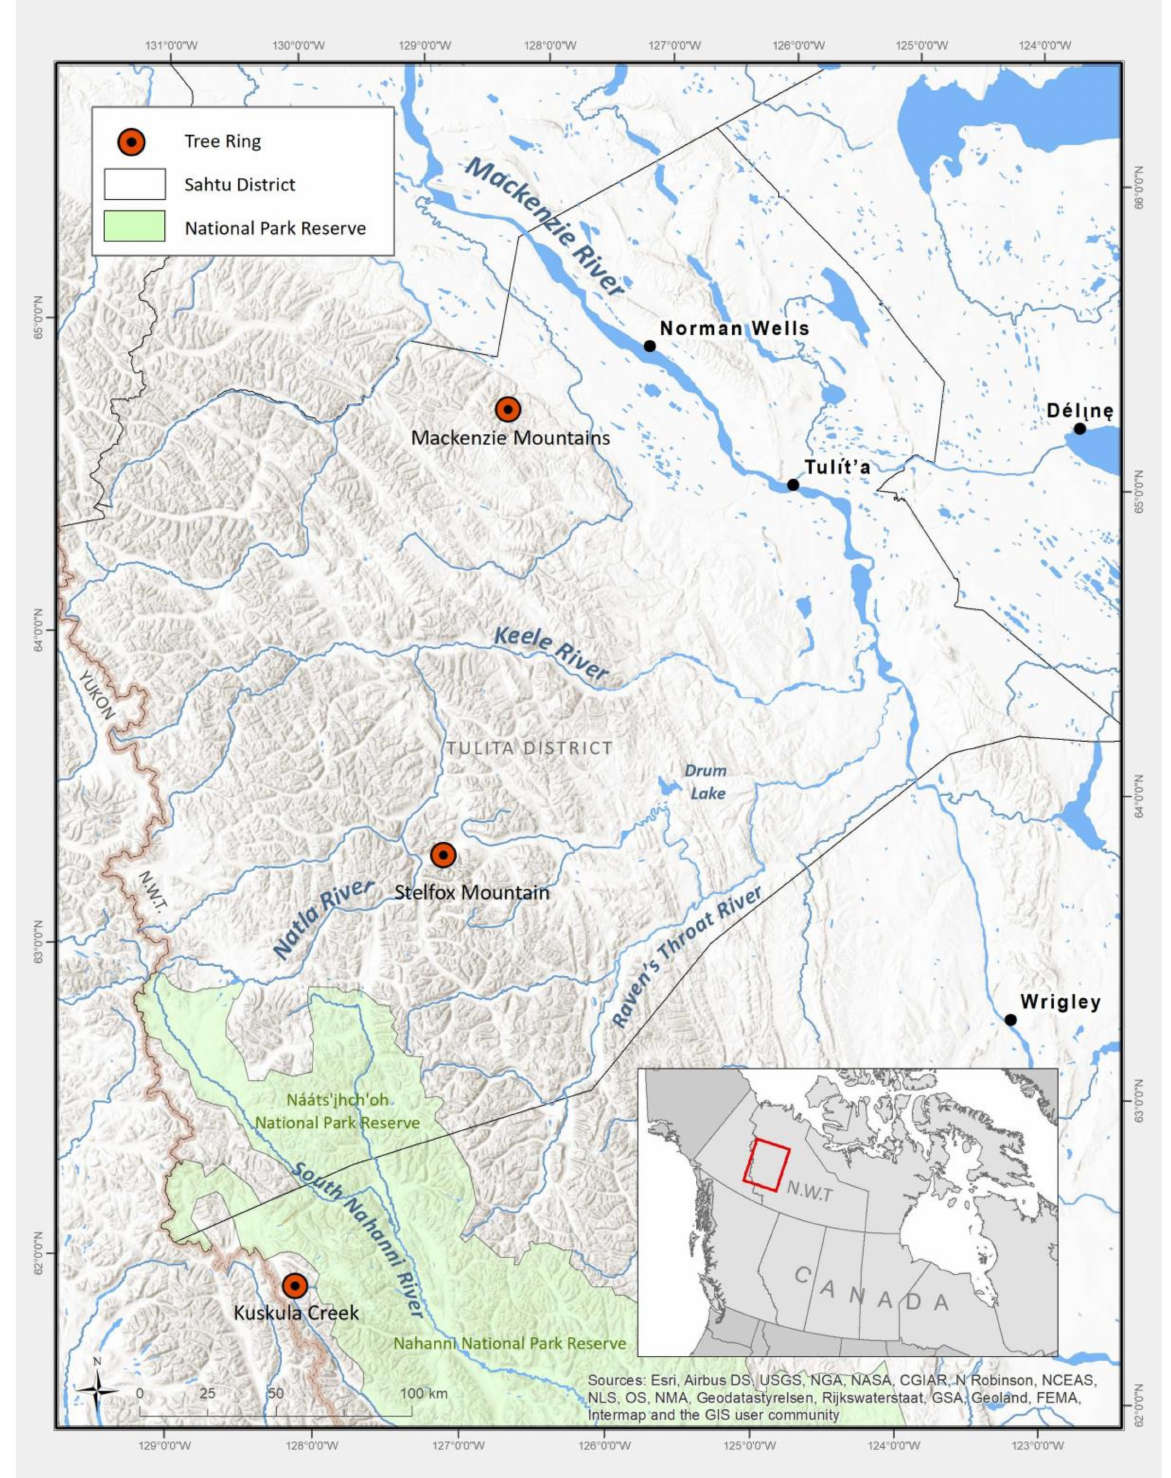
Figure 4. The location of the study site at the base of Stelfox Mountain in a remote section of the Mackenzie Mountains in the Northwest Territories. The closest towns are Norman Wells and Tulit’a, which are located on the Mackenzie River in NT. The two closest tree-ring chronologies to the study site are the “Mackenzie Mountain” chronology found north of the study site [19] and the “Kuskula Creek” chronology found to the south